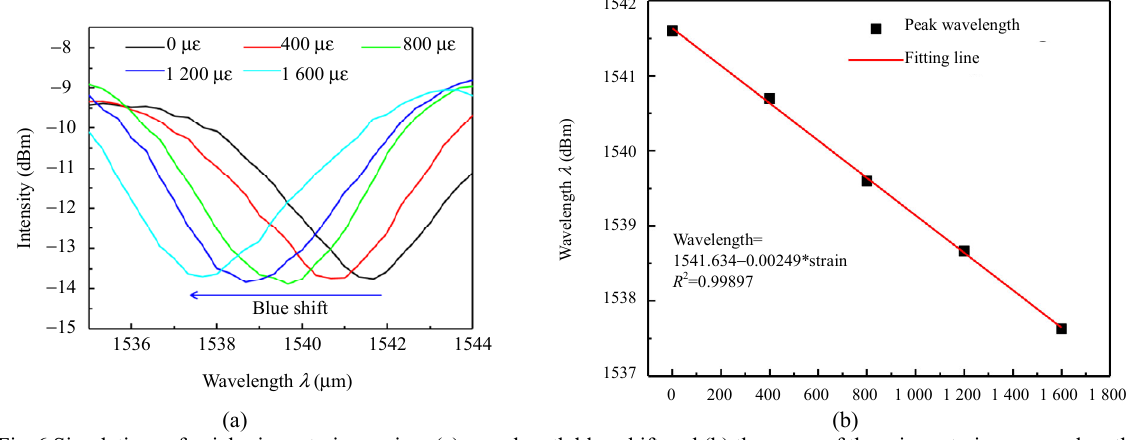
Fig. 6 Simulations of axial micro-strain sensing: (a) wavelength blue shift and (b) the curve of the micro-strain vs. wavelength.